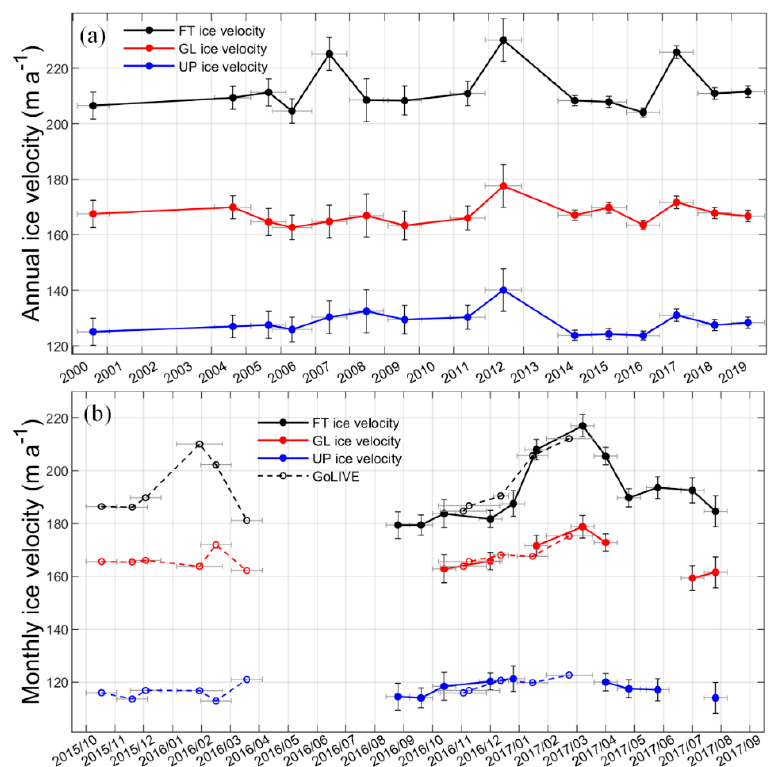
Figure 4. Variations in the ice velocity of Dalk Glacier. ( a ) Interannual velocity changes at the front (FT), grounding line (GL), and upstream (UP) regions in 2000–2019. ( b ) Seasonal velocity variations from October 2015 to September 2017. Vertical bars are error bars and horizontal bars are temporal baselines of the image pairs used in velocity calculation.